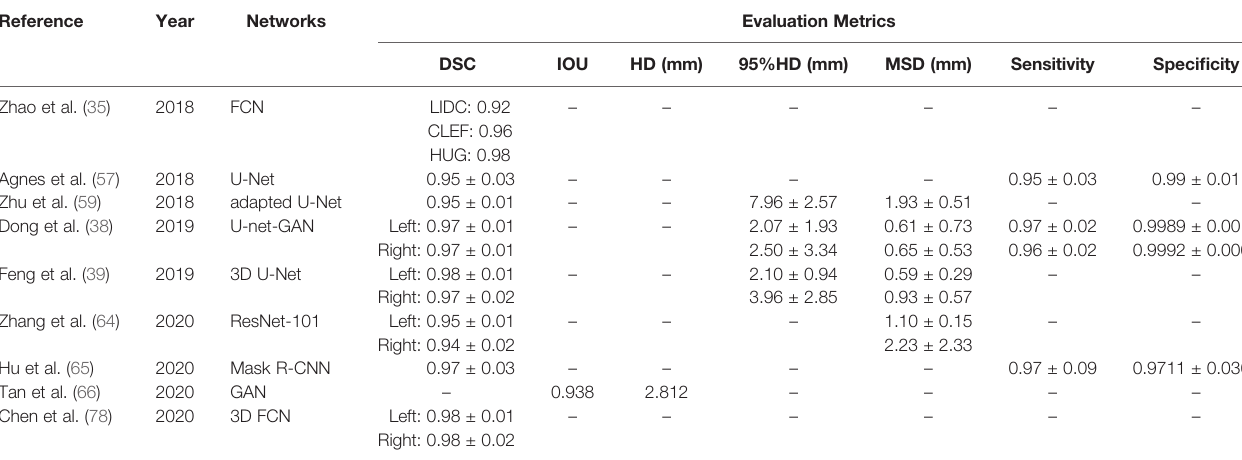
TABLE 2 | Comparison of selected works on segmentation of